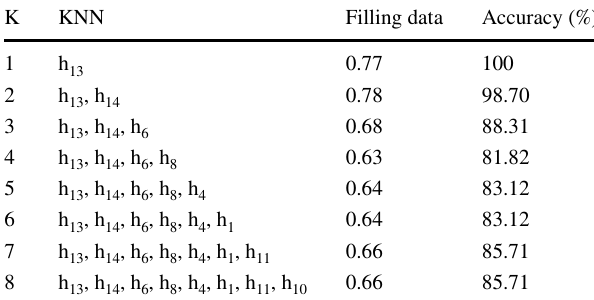
Table 5 The filling results of different K